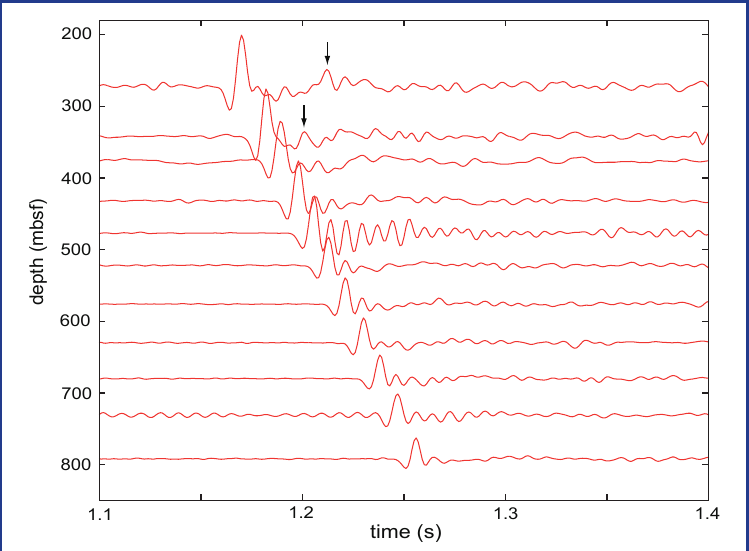
Figure 5. Filtered waveforms for checkshot experiment in upper part of Hole U1309D. Main arrival has strong signal-to-noise ratio. Removal of especially noisy traces brings out character of later arrivals. At upper stations, a secondary arrival (arrows) probably corresponds to D reflector of Canales et al., (2004).